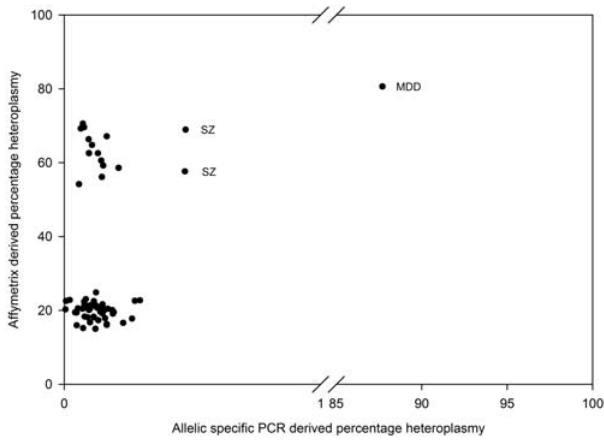
Figure 3. Scatter plot of the heteroplasmy levels of ND4L T10652C calculated from the Affymetrix mitochondrial rese- quencing chip by method of Coon etal. [ 65 ] on the y-axis and allelic specific PCR (x-axis truncated).